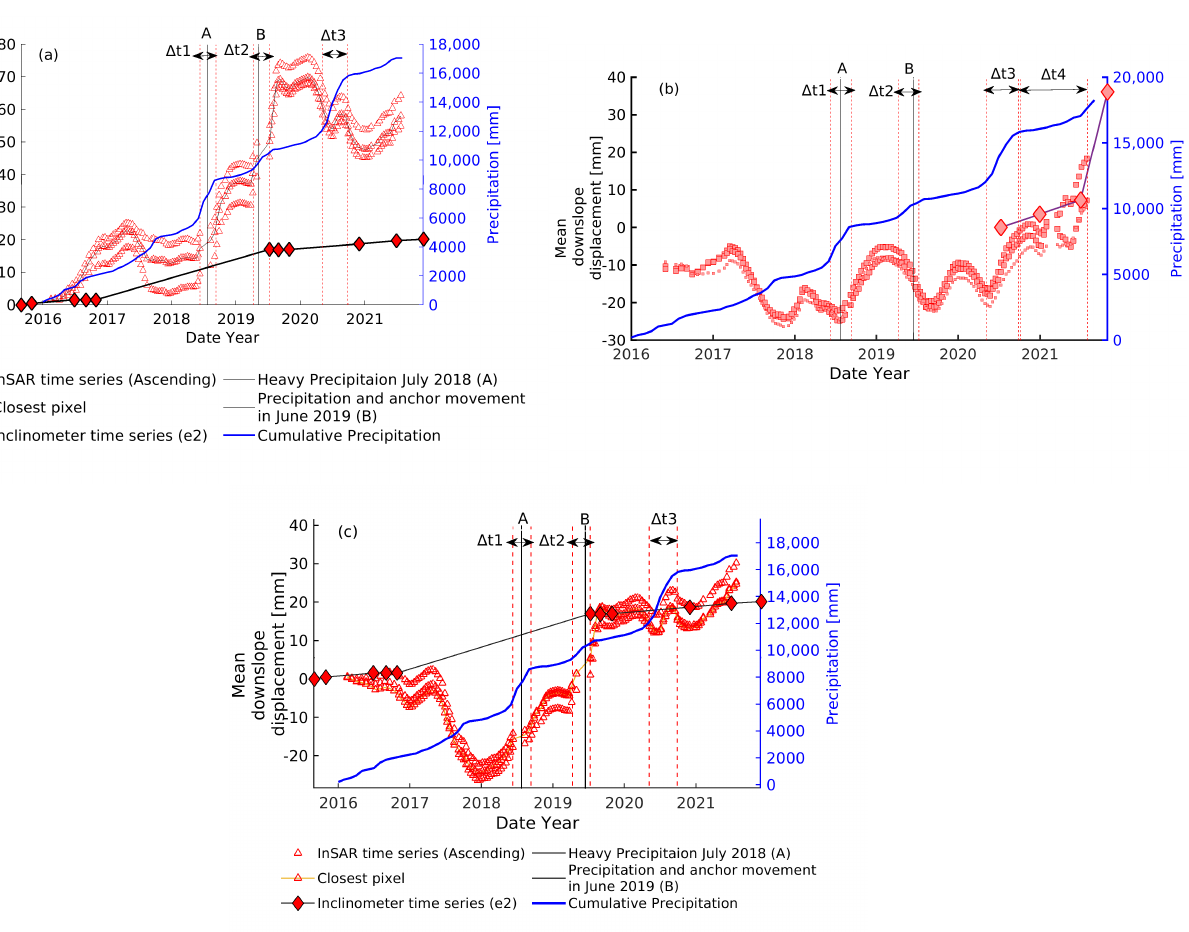
Figure 9. Trend comparison of the time series of the mean downslope displacement and horizontal inclinometer measurements along the maximum slope (e2 and TC-1). ( a ) This comparison defines the InSAR mean downslope displacement of the S-1 ascending track and inclinometer displacement increments in the e2 region over three periods: ∆ t 1, ∆ t 2, and ∆ t 3. The first two increments, ∆ t 1 and ∆ t 2, show ground deformation in the presence of ground anchors, while ∆ t 3 represents stable readings of the InSAR and borehole inclinometer time series due to anchor elongation, despite the large increments in cumulative precipitation. ( b ) Comparison between the InSAR mean downslope movement based on the S-1 descending track and the inclinometer observations in the TC-1 area in four periods: ∆ t 1, ∆ t 2, ∆ t 3, and ∆ t 4, with the fourth period representing high mean downslope displacement increments driven by high cumulative precipitation in 2020 and 2021, when groundwa- ter springs were observed on the surface. The inclinometer locations in the e2 and TC-1 areas are illustrated in Figures 3, 4 and 8. ( c ) Mean downslope time-series displacement after the application of the RF mask in the e2 region; there is a correlation between the cumulative displacement from the ground inclinometer and the InSAR mean downslope time series that is stronger than the correlations presented in ( a